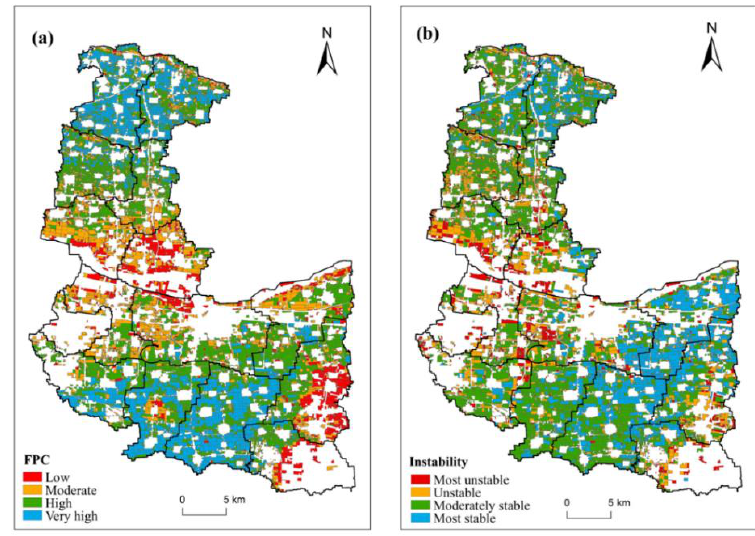
Figure 9. Classification map of FPC.